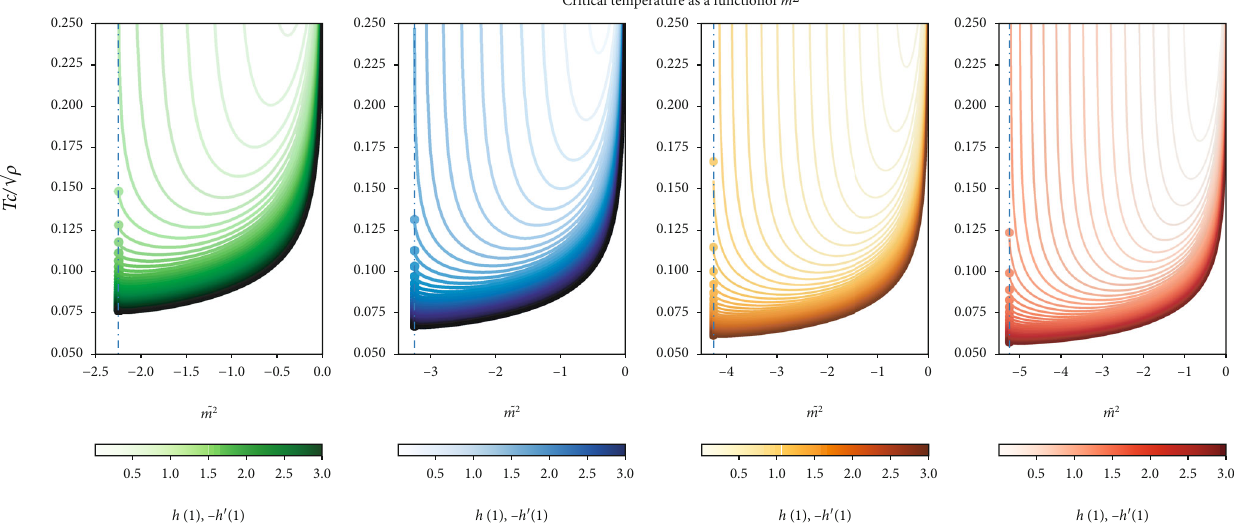
Figure 3: Critical temperature in units of the charge density ρ for s-, p-, d-, and f-wave superconductors as a function of ~ m 2 and h ð 1 Þ under the assumption that h ′ ð 1 Þ = − h ð 1 Þ . Di ff erent curves denote di ff erent choices for h ð 1 Þ , the prefactor of the metric at the horizon. Brighter colours refer to small values of h ð 1 Þ close to zero and darker colours to h ð 1 Þ close to 3. The dashed blue vertical line symbolises the Breitenlohner-Freedman bound, Equation (38), for each